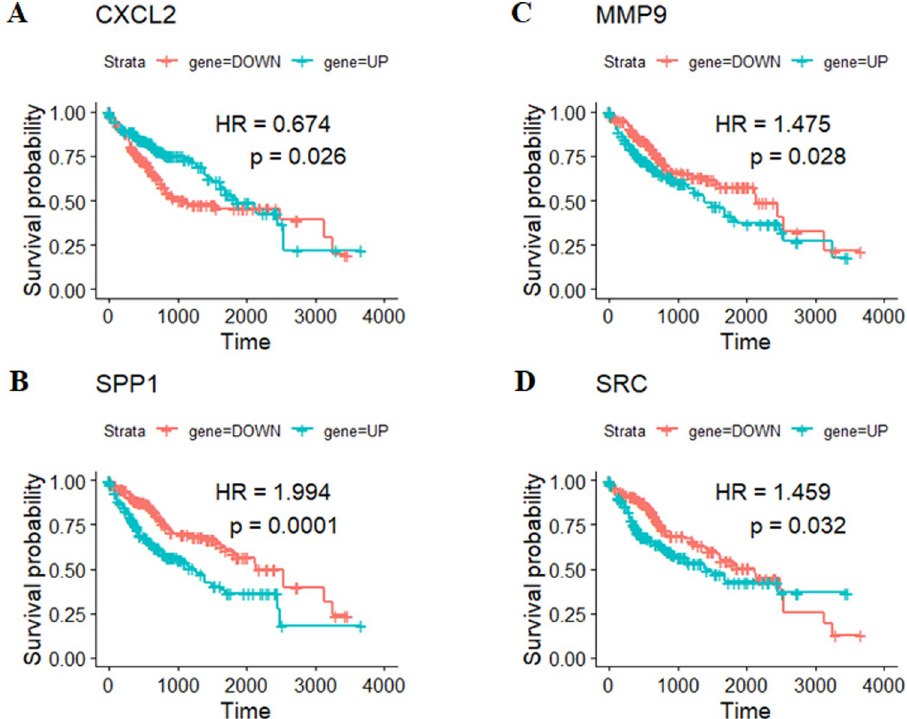
Fig 5. Association of the overall survival and four potential hub genes (A) CXCL2 ; (B) MMP9 ; (C) SPP1 ; (D) SRC in HCC based on Kaplan–Meier plotter. The horizontal axis signifies the time to event (in days). The patients were stratified into the high- and low-risk-level group and labeled with green and red color, respectively. HR is the hazard ratio of the high-risk over low-risk groups and p < 0.05 indicates a statistically significant difference.